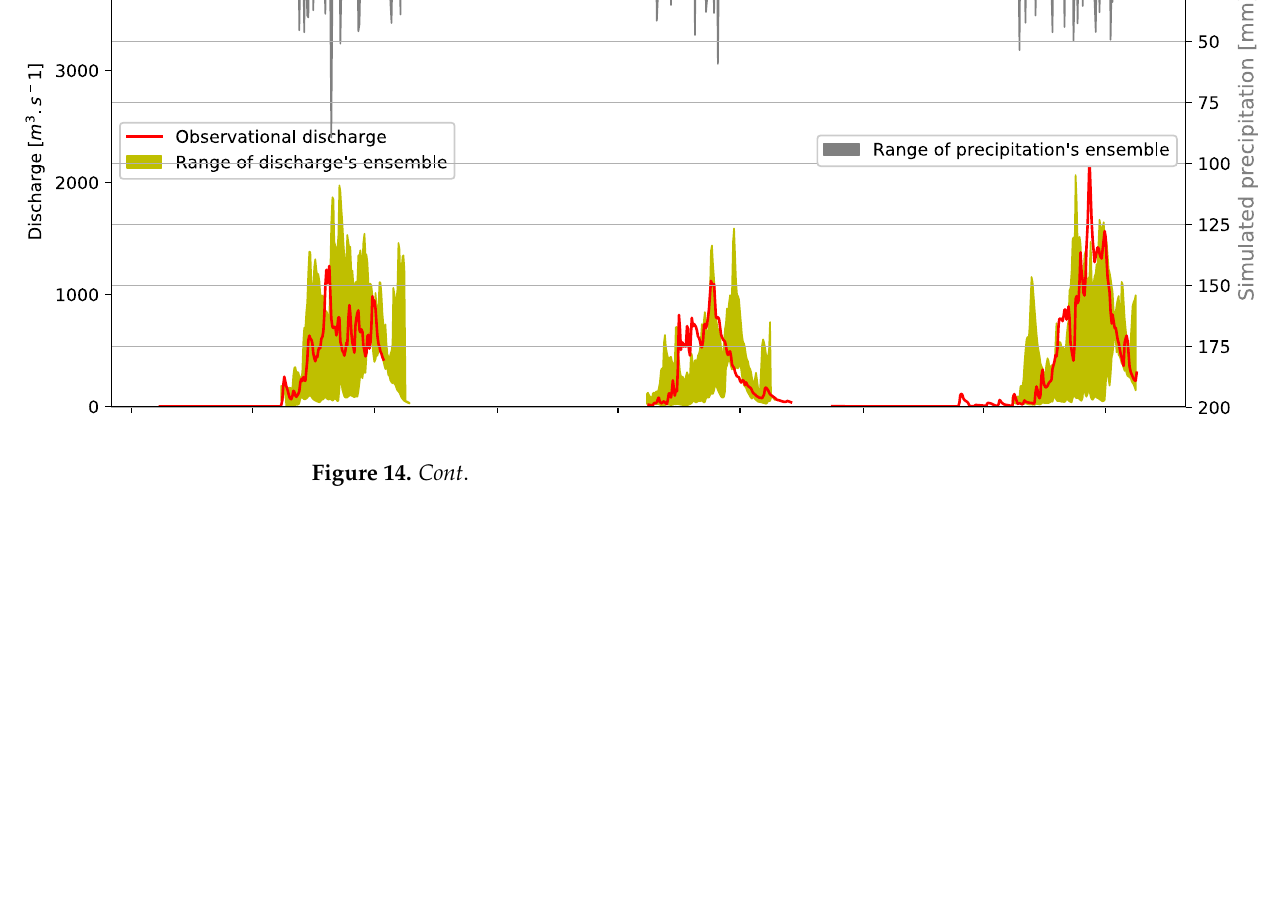
Figure 14. Ensemble (WRF-Hydro-SKEBS) of simulated hydrographs and precipitations at Savè and Bétérou. 4. Summary and Conclusions The present study explored the abilities of the fully coupled WRF-Hydro modeling system to simulate discharge and precipitation in the Ouémé river in West Africa. The main objective of the study was to determine an accurate flood forecasting tool that ex- hibits the interaction between atmosphere and land surface models, since the feedback of these interactions impact the precipitation dynamic [62,65]. Therefore, the supplementary hydrological extension of WRF model has been calibrated in offline mode for one year, and tested for two years using hourly outputs from WRF simulations. Optimized param- eters from the calibration were used to perform the fully coupled WRF-Hydro model, which was used to investigate the forecasting performance skills of WRF over the Ouémé. We have found that the coupled modeling system WRF-H performed slightly better re- garding the precipitation episodes than the WRF-only model (as already illustrated by [ 66 ] over the interested period (2008–2010)). The evaluation of simulated precipitation showed its good performance skills, and provides confirmation about the uncertainty of WRF-H to simulate precipitation [43,46].